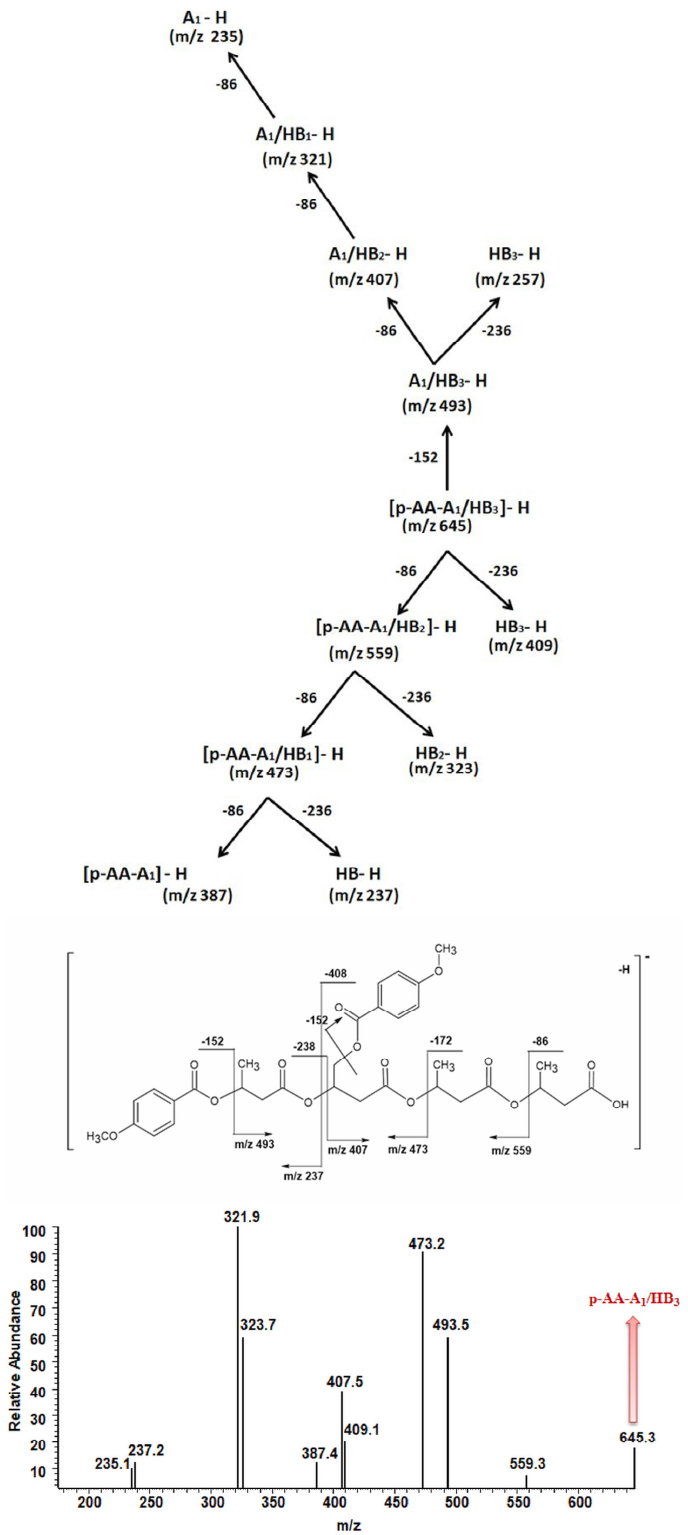
Figure 4. ESI-MS 2 spectrum (performed in negative-ion mode) of [p-AA-A 1 / HB 3 ] (co)oligoester ion at m / z 645 with carboxylic and p-anisate end groups and possessing one p-AA-CH 2 -HP comonomer unit together with the theoretical fragmentation